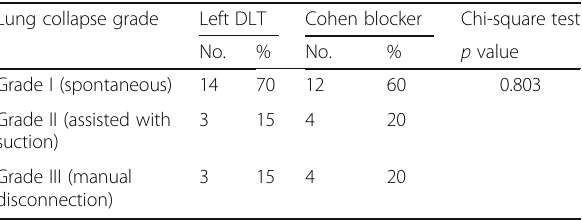
Table 4 Comparison of lung collapse assessment grades Lung collapse grade Left DLT Cohen blocker